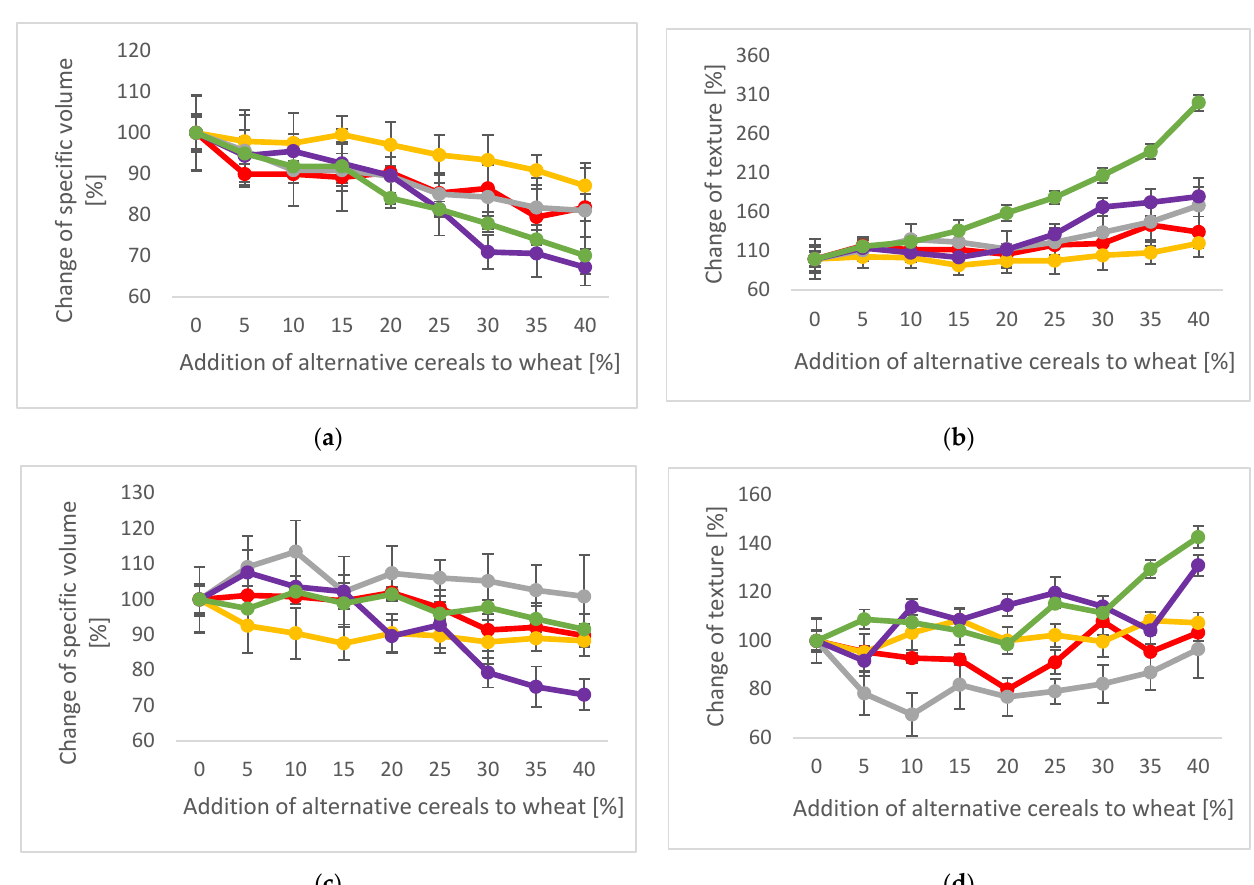
Figure 3. Physical baking properties; Red: Red sorghum, Yellow: White sorghum, Grey: Millet, Purple: Amaranth, Green: Buckwheat. The 100% wheat bread was defined as a reference. The data show the specific volume and crumb firmness compared with the reference (100% wheat). ( a ) Change of specific volume (%) of the standard wheat bread (SWB); ( b ) change of crumb firmness (%) of the SWB; ( c ) Change of the specific volume (%) of the sweet milk wheat bread (MWB); ( d ) Change of crumb firmness (%) of the MWB.